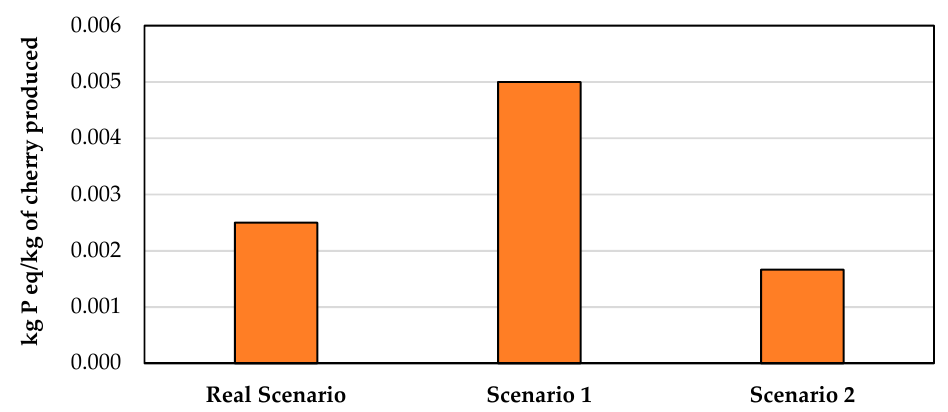
Figure 5. Freshwater eutrophication for the FU of 1 kg of produced cherry for the real and test scenarios, considering the phosphorus fertilizer environmental impact.